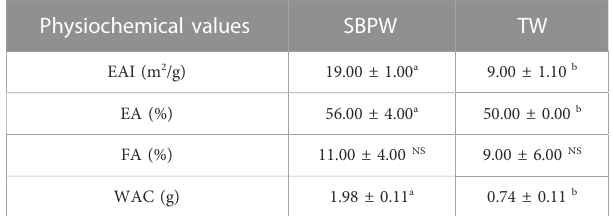
TABLE 1 Physiochemical properties of the foaming agents (SBPW and TW). Properties analyzed were EAI (emulsifying activity index), EA (emulsifying ability), FA (foaming ability), andWAC (water absorptioncapacity). Data inthe same row that do not share the same letter are signi fi cantly different ( α 0.05). NS means non-signi fi cant.